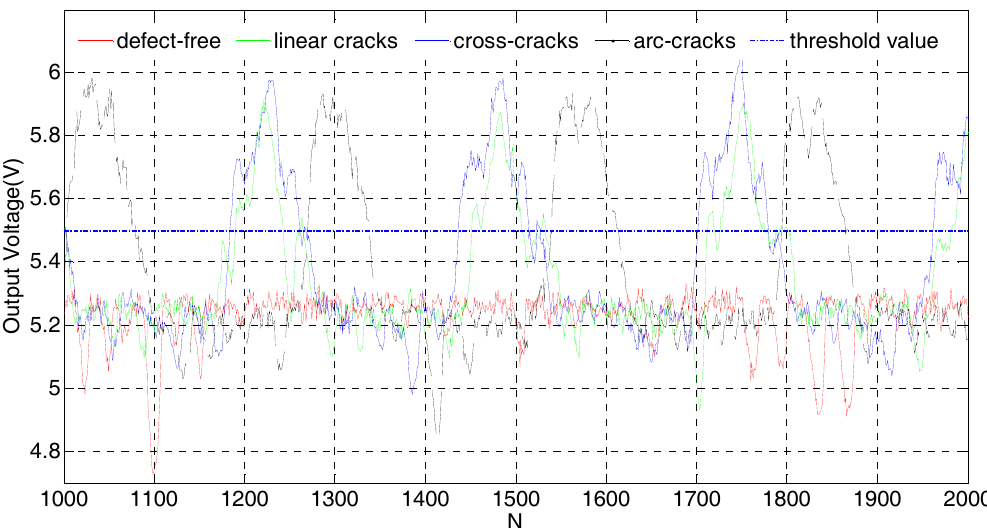
Figure 10. Excerpted diagram of 1000 – 2000 points from the 5000 points of the inspection signal. The threshold value of 5.5 V was used to distinguish whether the steel ball has a defect or not.